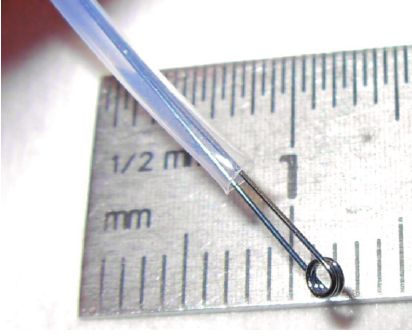
Figure 3. Photograph of a sensing head with one complete chalcogenide glass fiber loop.